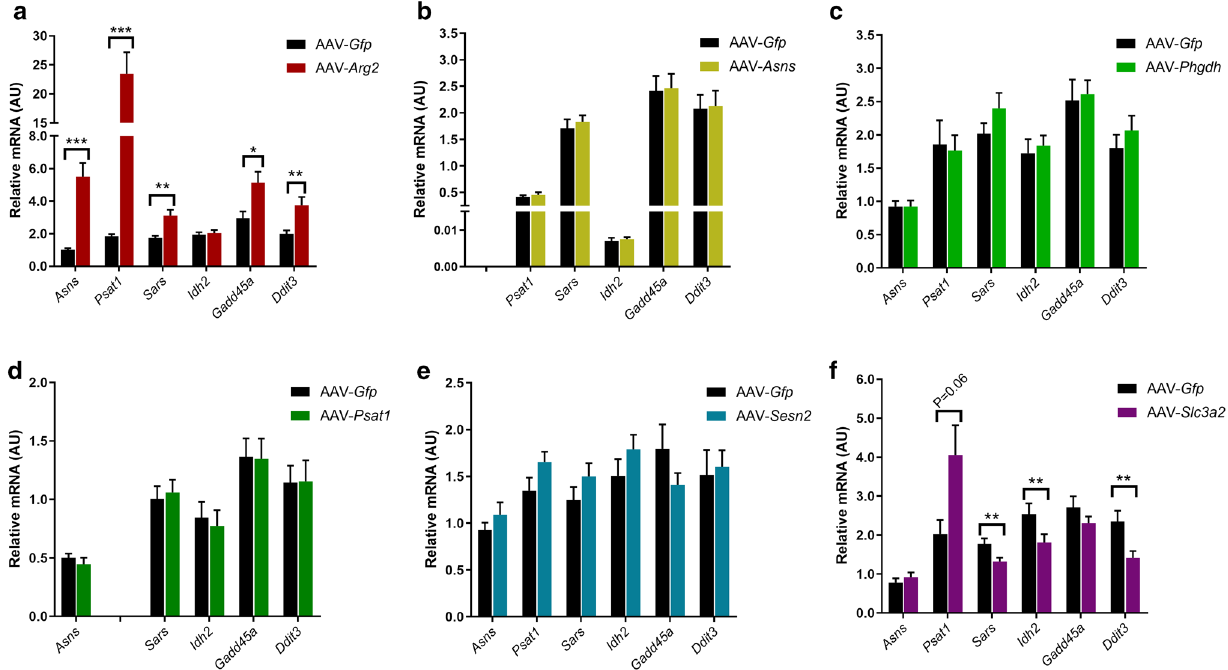
Figure 4. Effect of AAV-mediated overexpression of genes associated with an integrated stress response (ISR) on endogenous mRNA expression. Relative mRNA expression for Asparagine Synthetase ( Asns ), Phosphoserine Aminotransferase-1 ( Psat1 ), Seryl-tRNA Synthetase ( Sars ), Isocitrate dehydrogenase-2 ( Idh2 ), Growth Arrest And DNA-Damage-Inducible 45 Alpha ( Gadd45a , also known as Ddit1 ) and DNA Damage Inducible Transcript 3 ( Ddit3 , also known as CHOP ) were determined in the Extensor Digitorum Longus (EDL) muscle following 28 days AAV-mediated overexpression of ( a ) Arg2 , ( b ) Asns , ( c ) Phgdh , ( d ) Psat1 , ( e ) Sesn2 and ( f ) Slc3a2 . Relative Asns and Psat1 mRNA expression were excluded from AAV- Asns and AAV- Psat1 data respectively as these were reported in Fig. 2. All mRNA expression data were normalised to OliGreen, as a measure of total cDNA. Data presented as Means (n = 8, except AAV- Sesn2 n = 10) ± SEM. *( P < 0.05) **( P < 0.01) and ***( P < 0.001) indicate significantly different to contralateral control limb injected with AAV- Gfp